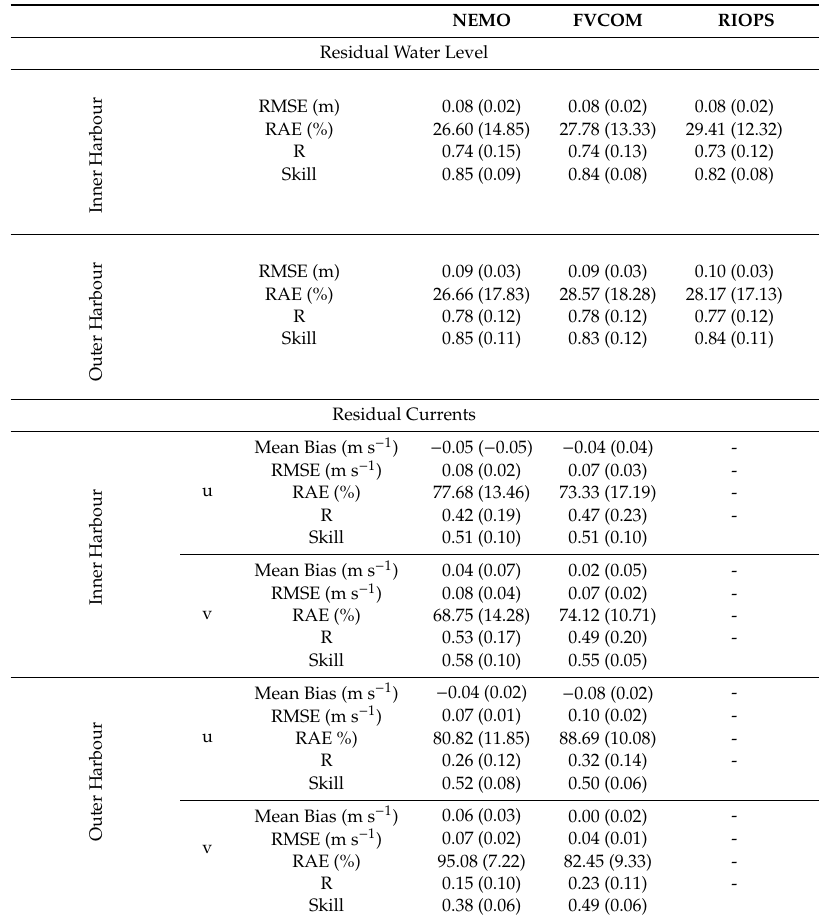
Table 3. The evaluation metrics for the residual water level and currents (see definitions in Equations (5)–(8) and in text), averaged for the stations in the inner and outer SJH, separately. Numbers in brackets are the standard deviations across the stations. RMSE, RAE, R and Skill are defined in Equations (6)–(9). Note that for the water levels, the mean bias is not computed and the other metrics are computed for the demeaned time series. Water level metrics are computed for NEMO, FVCOM and RIOPS. Current metrics are computed for NEMO and FVCOM